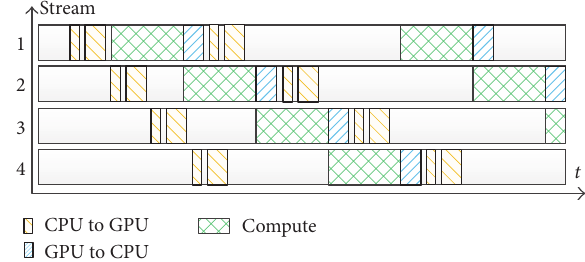
Figure 11: Overlapping between communication and computation on GPU context.